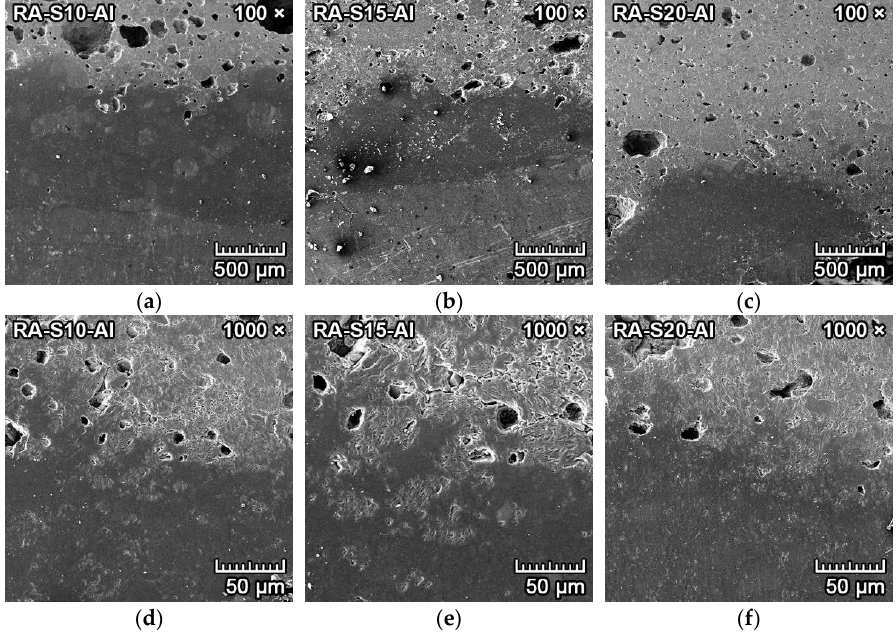
Figure 11. SEM microstructure of the transition zone between aluminum (dark grey and smooth) and forsterite – spinel ceramics (lighter and porous) of reactive alumina – based mixtures RA-S10, RA-S15 and RA-S20, with a magnification of 100× ( a – c ) and a magnification of 1000× ( d – f ). Figure 11a – f illustrates the corrosion resistance to aluminum of reactive alumina – based mixtures RA-S10, RA-S15 and RA-S20. The darker grey layer in the middle of Figure 11a,b and in the bottom of 11c represents the layer of oxidized aluminum. The corrosion resistance of reactive alumina – based mixtures to aluminum metal was very good, with a depth of penetration of aluminum of 0.2 – 0.6 mm for reactive alumina – based mixtures. The layer of oxidized aluminum (dark grey) was very thin in mixtures RA-S15 and RA- S20 due to the higher content of spinel, which also led to better corrosion resistance of these mixtures. 3.4.4. Corrosion Resistance of Ceramics to Copper The microphotographs from SEM of the transition zone between copper and forster- ite – spinel ceramics are presented in Figures 12 and 13. The SE detector could clearly dis- tinguish between the copper metal (lighter and smooth) and ceramics (darker and po- rous). The transition zone between copper and ceramics is clearly visible in the middle of Figures 12a – c and 13a – c. Between the copper metal and the ceramics is a very thin layer of a few micrometers that is darker than the copper metal and lighter than ceramics (mid- dle of Figure 12d – f). The EDX probe detected that this thin layer was composed primarily of melted copper, which filled the pores of the ceramics, and part of the copper that oxi- dized into copper oxide (CuO). The bottom halves of Figure 12a – c contain almost pure copper, with small quantities of copper oxide.